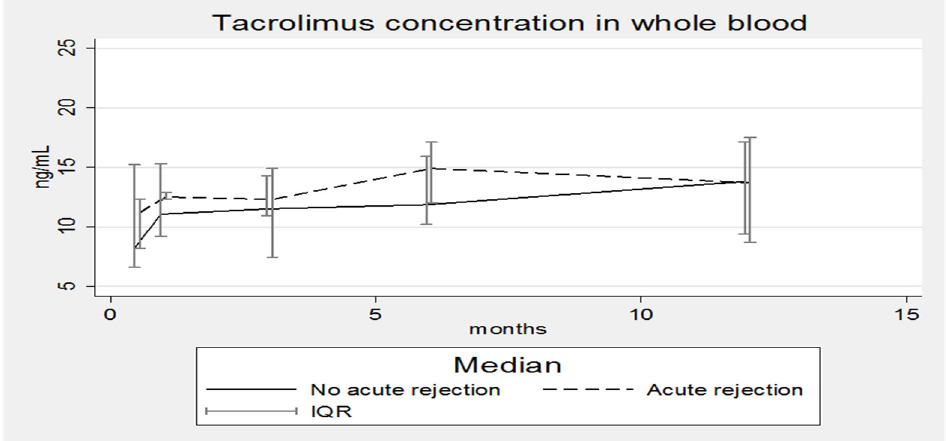
Figure 6. Median concentration–time profile of Tacrolimus in whole blood with and without acute rejection episodes. IQR: interquartile range. No correlation was found between TAC concentrations in EMBs and whole blood, considering all patients together as a single group and as subgroups of RPs or